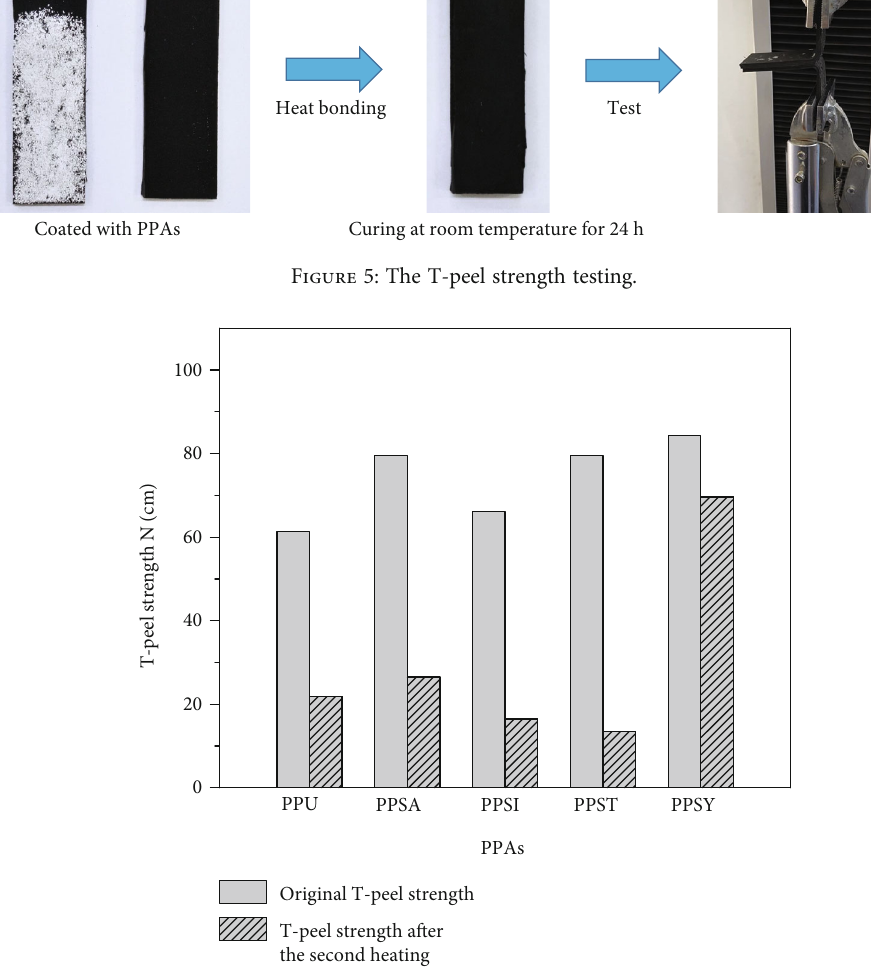
Figure 6: The T-peel strength of the PPAs.